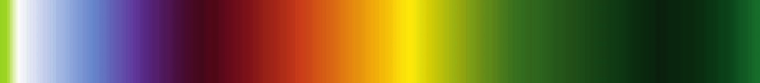
Figure 1: The colormap used for generating